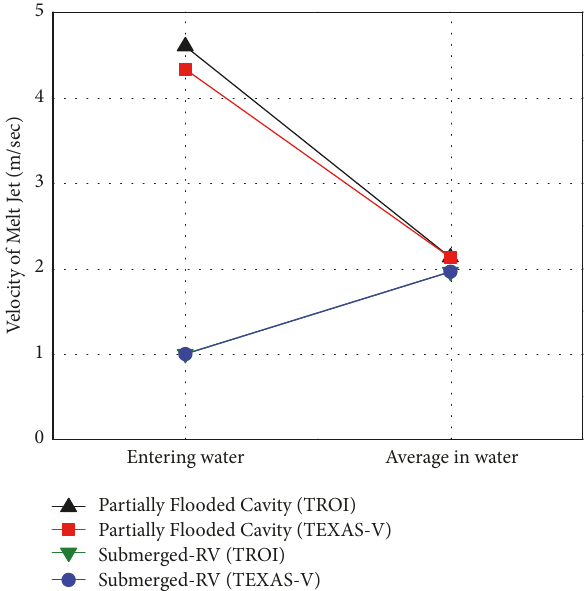
Figure 8: Void fractions in TROI experiment and TEXAS-V simulation for the submerged-RV condition.